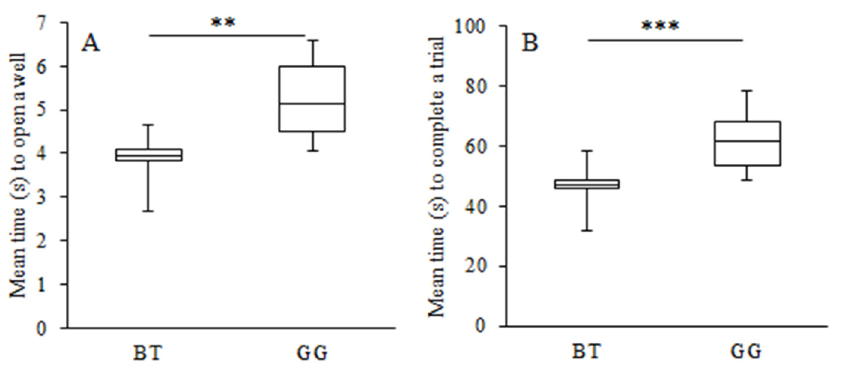
Figure 7. Box plot of mean time (s) to ( A ) open a well and ( B ) complete a trial (BT = Blue-throated Macaws, GG = Great Green Macaws). ** p < 0.01, *** p = 0.001.